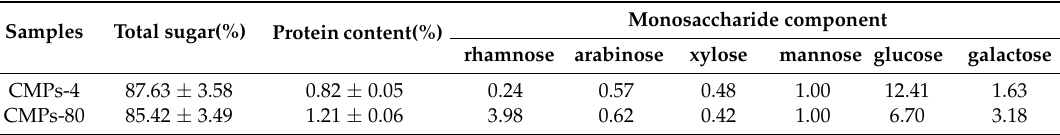
Table 1. Contents of total sugar and protein, monosaccharide composition and their molar ratio of CMPs-4 and CMPs-80 (mean ± s, n =